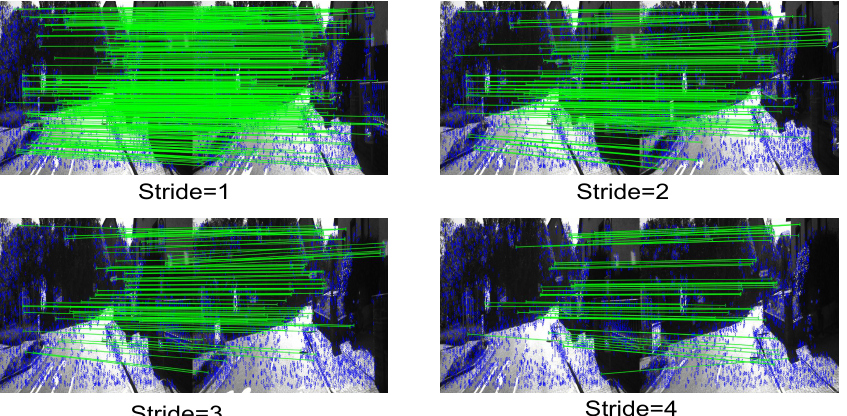
Figure 5. Number of matched corresponding point pairs using SURF+FLANN. As shown, when the movement gets faster (the larger the stride is), the number of found matches